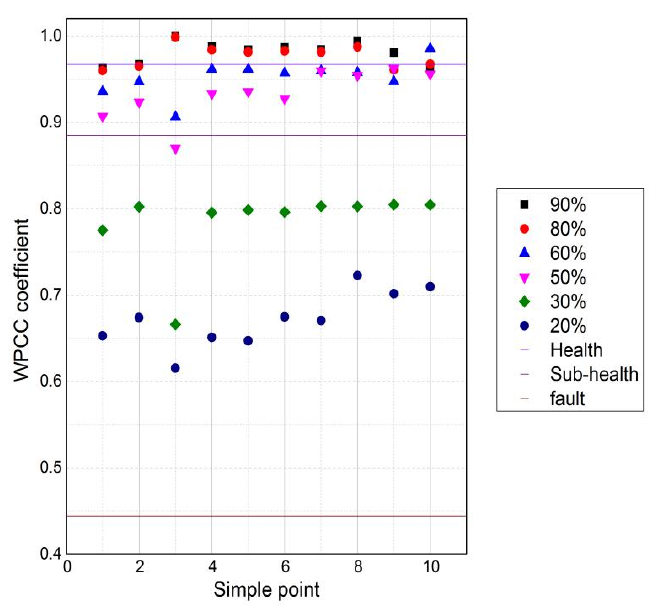
Figure 7. Test results at the speed of 200 km / h.